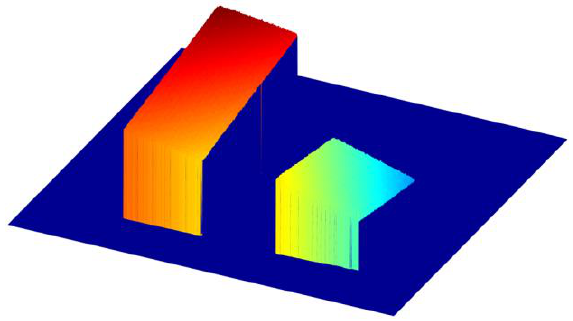
Figure 16. Measurement result of two planes.